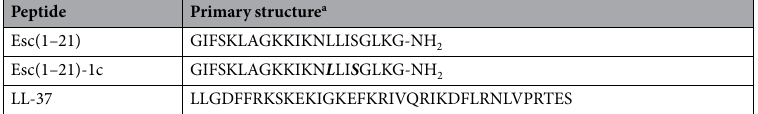
Table 1. Primary structure of the peptides under study. a d-amino acids are in italics and